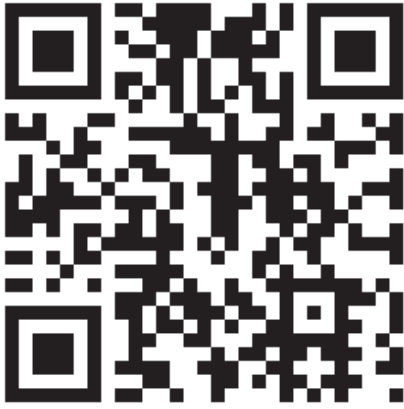
Figure 11: YouTube link [16]: highway